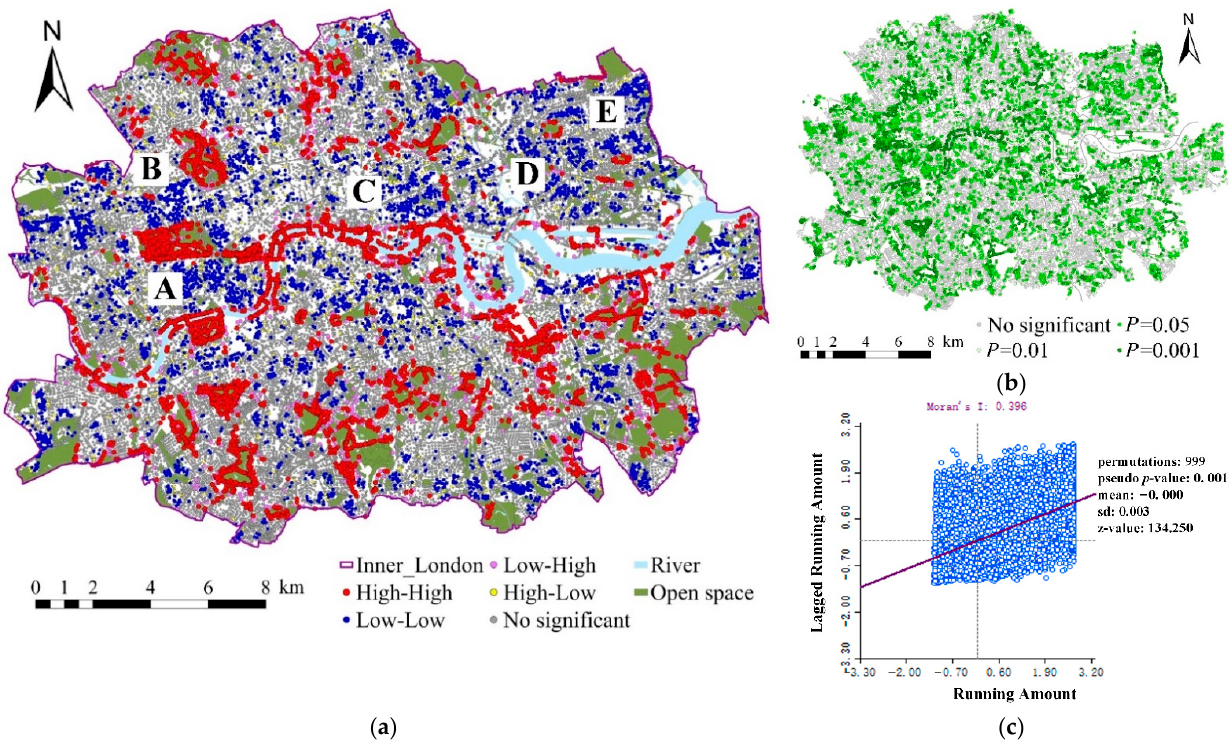
Figure 8. ( a ) LISA cluster map of the running amount based on 40,290 sample points, position A–E indicates the representative area where low–low values appear; ( b ) the LISA significance level map; ( c ) Moran’s I test of running amount, which showed a positive spatial autocorrelation.